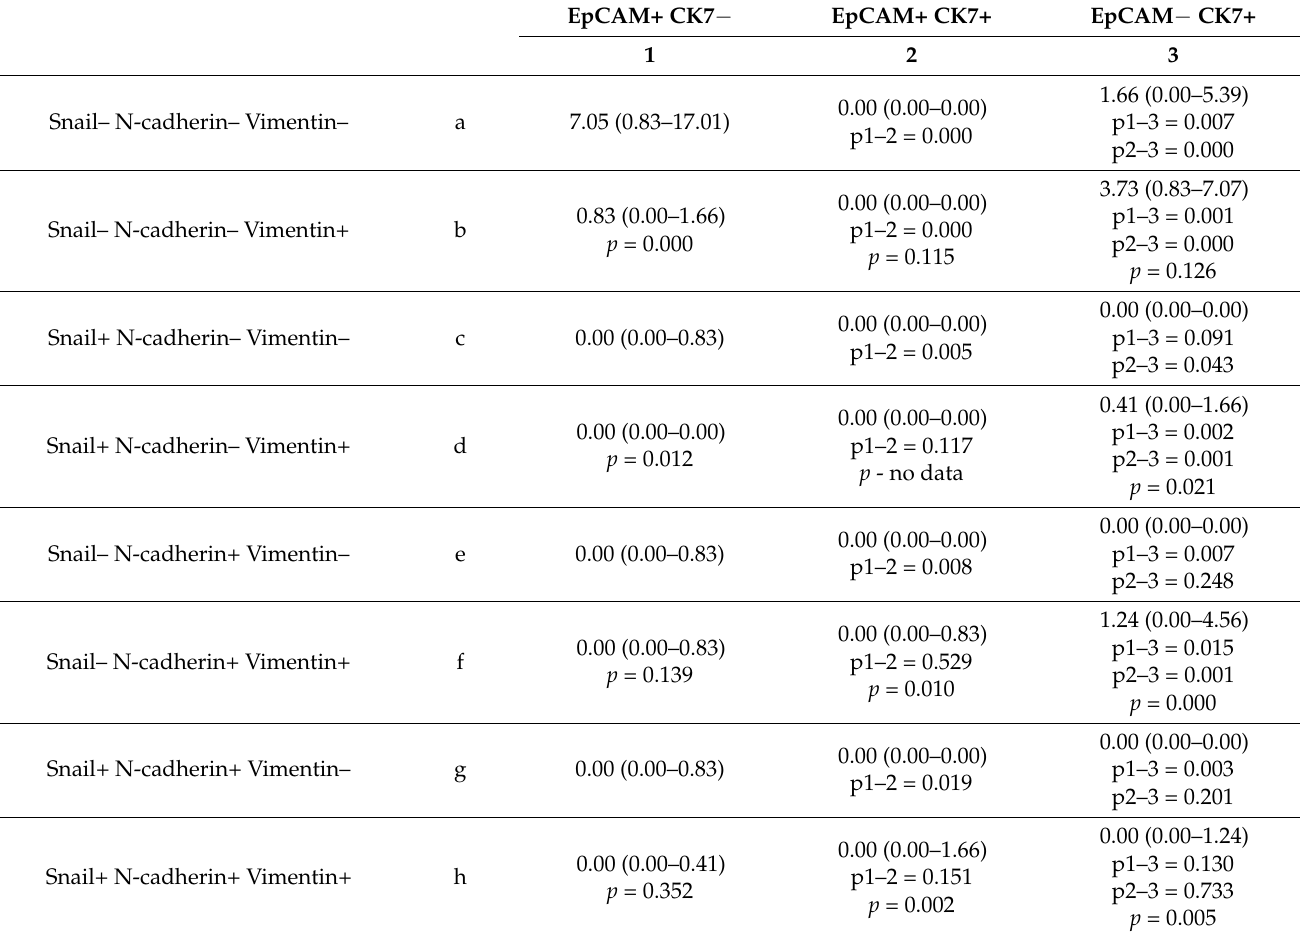
Table 1. The number of different CTC subsets with heterogeneous manifestations of EMT.